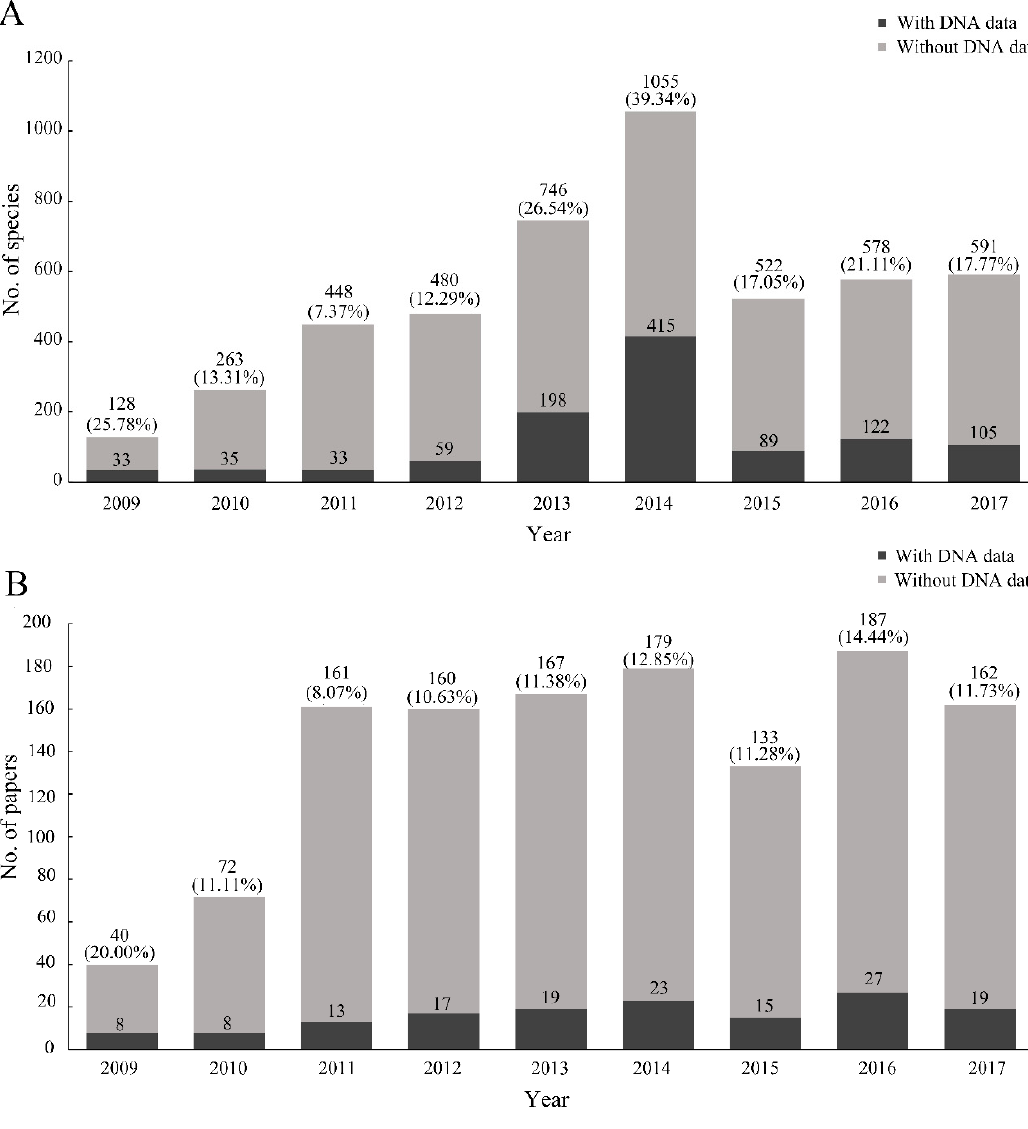
Figure 4. The usage of DNA data in species description from 2009 to 2017. ( A ) Numbers of new species with DNA data (dark gray) as well as the total numbers of species (values before parentheses). ( B ) Numbers of papers with DNA data (dark gray) as well as the total numbers of papers (values before parentheses). The percentages are indicated in parentheses.